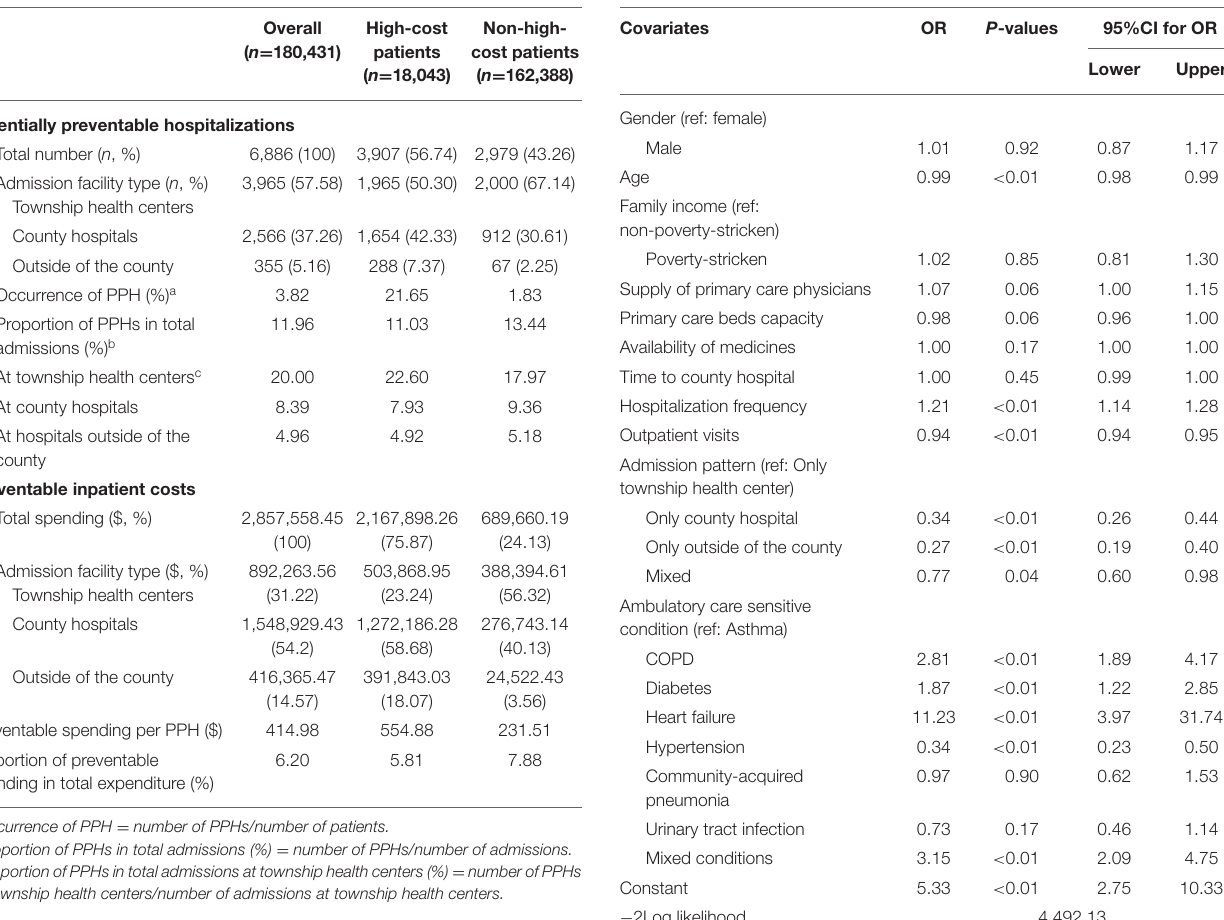
TABLE 2 | Occurrence and costs of potentially preventable hospitalizations among high-cost and non-high-cost patients.